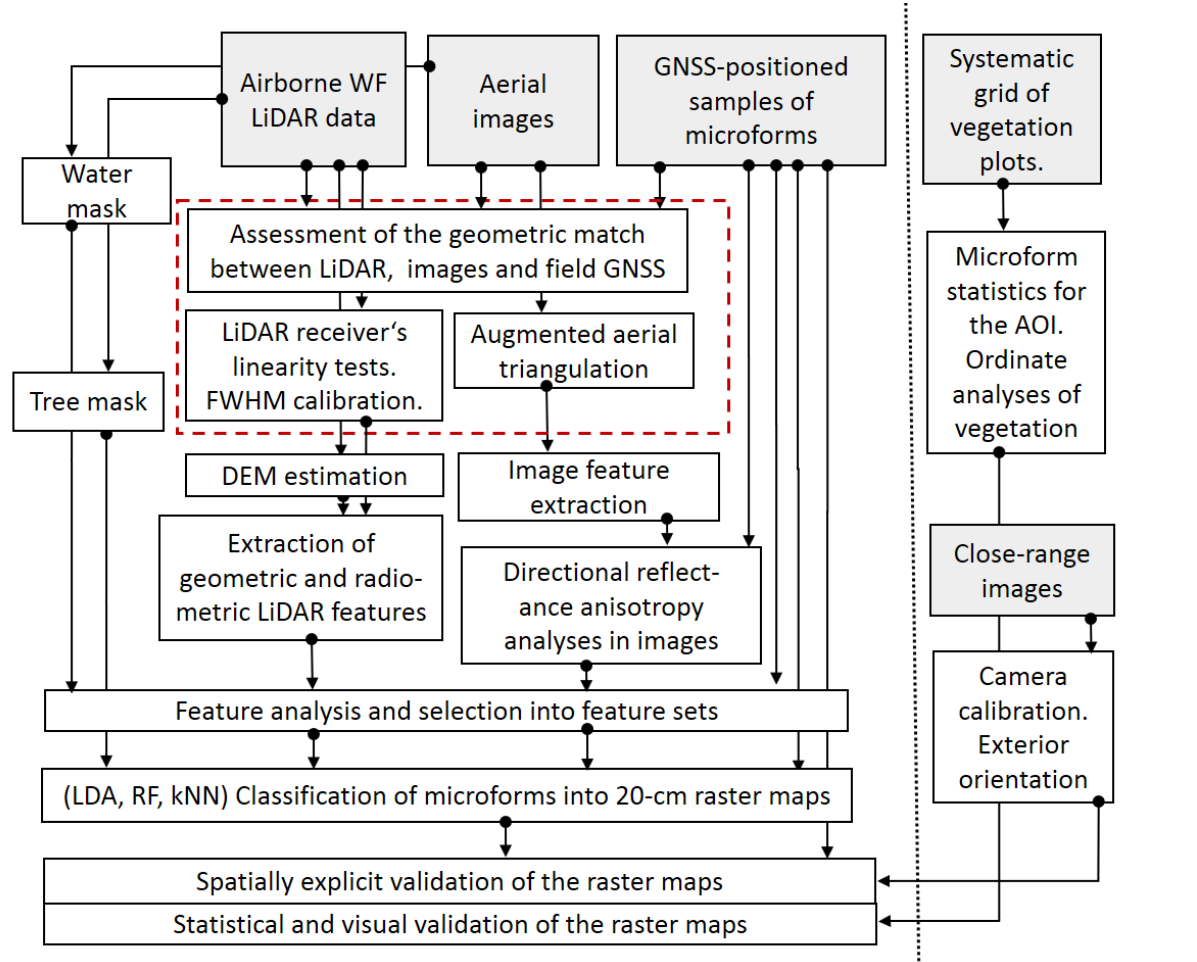
Figure 3. Flowchart of this study. The primary data and processing steps are shown to the left of the dotted line, while the data that were used for visualisation and spatially implicit validation are to the right. The red dashed rectangle identifies additional tasks that ensured data quality. See text for further